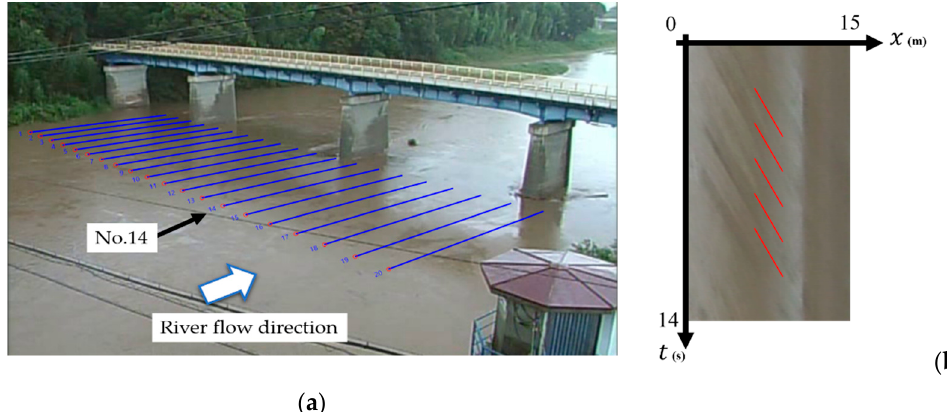
Figure 11. Shadow case: Part of the search line crosses the shaded area created by the bridge. The STI shows a non-uniform texture. ( a ) Obliquely viewed image; ( b ) STI, No.14 (red lines are CNN estimated angles).